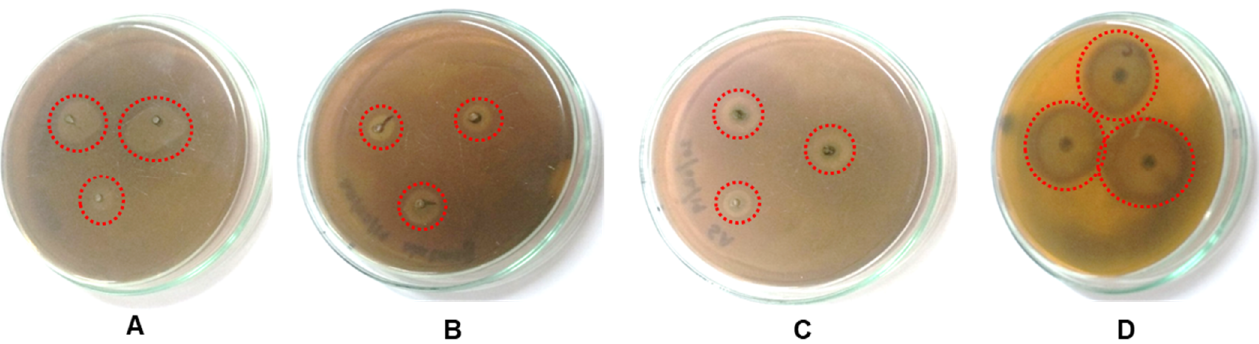
Figure 9. Growth of S. aureus showing zones of inhibition (circled in red) of CuNPs formulated with spice extract: ( A ) star anise, ( B ) nutmeg, ( C ) mace, and ( D ) gentamycin (positive control) with a well-diffusion method. Table 5. ZOI values of CuNPs synthesized with extracts of spices using a well-diffusion method. Spices